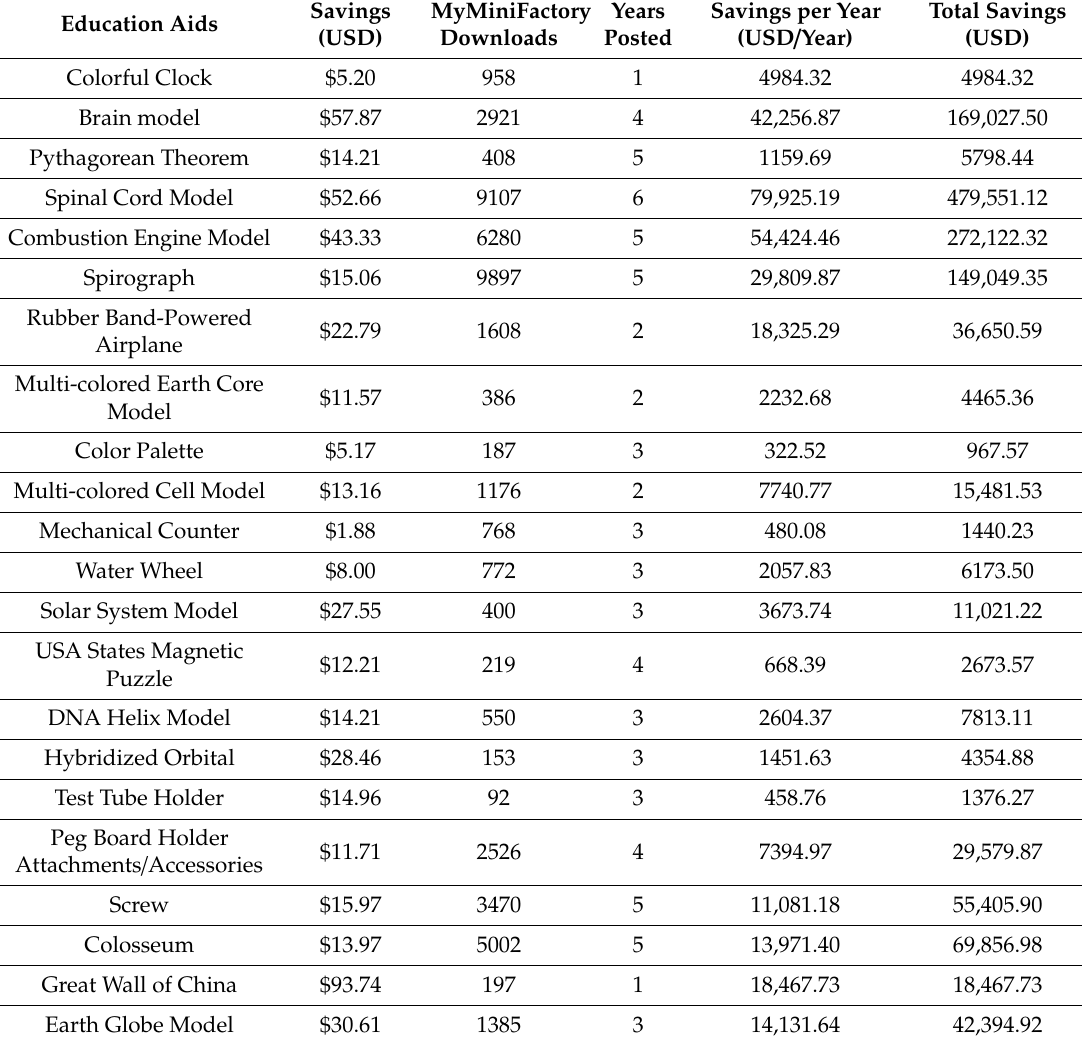
Table 4. Global savings from demonstrated downloading of learning aids evaluated as a function of year and